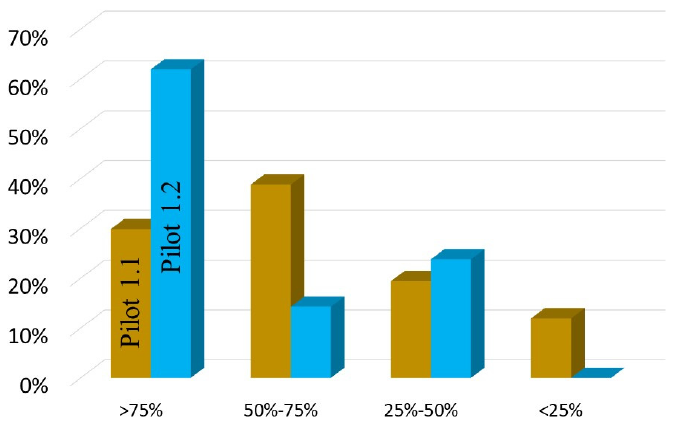
Figure 1. Percentage of students who finished the weekly goals. Results are divided into quartiles. Table 4. Pearson coefficients for user types vs. kind of activities.